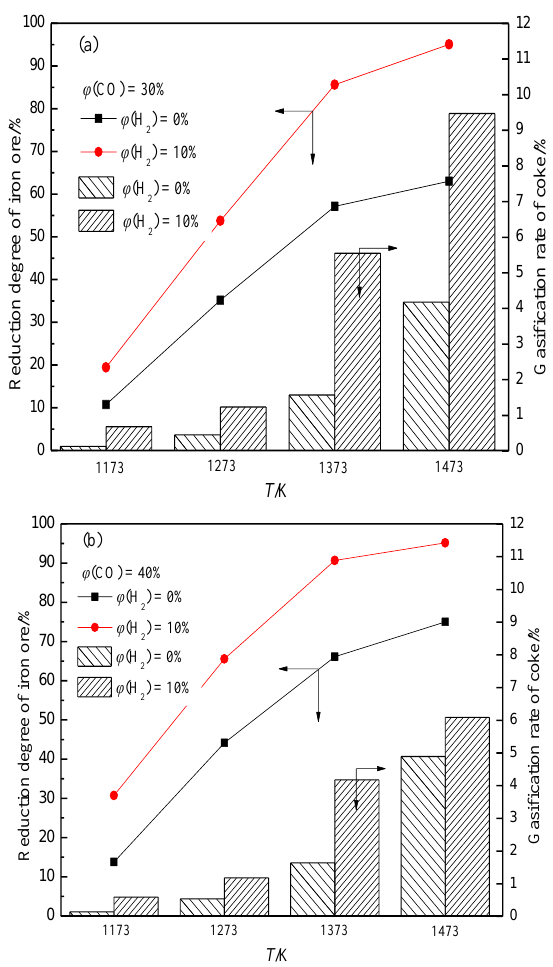
Figure 6. Effects of H 2 on reduction degree of iron ore and coke gasification rate under different conditions, adopted from [67]. ( a ) φ ( CO ) = 30%; ( b ) φ ( CO ) = 40%.